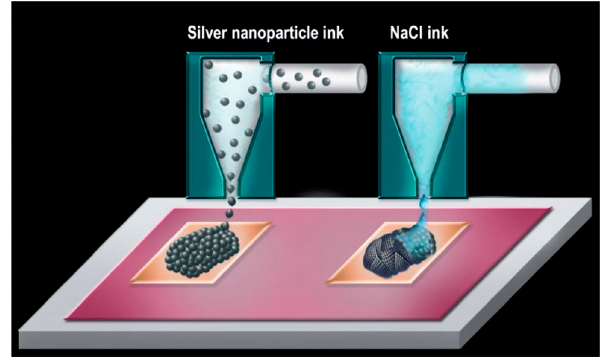
Figure 2. Scheme of the double printing process. First, a pattern of Ag NPs based ink is printed, followed by printing a salt solution on top of the silver pattern. Reproduced with permission from [59]; Copyright 2012 Royal Society of Chemistry.